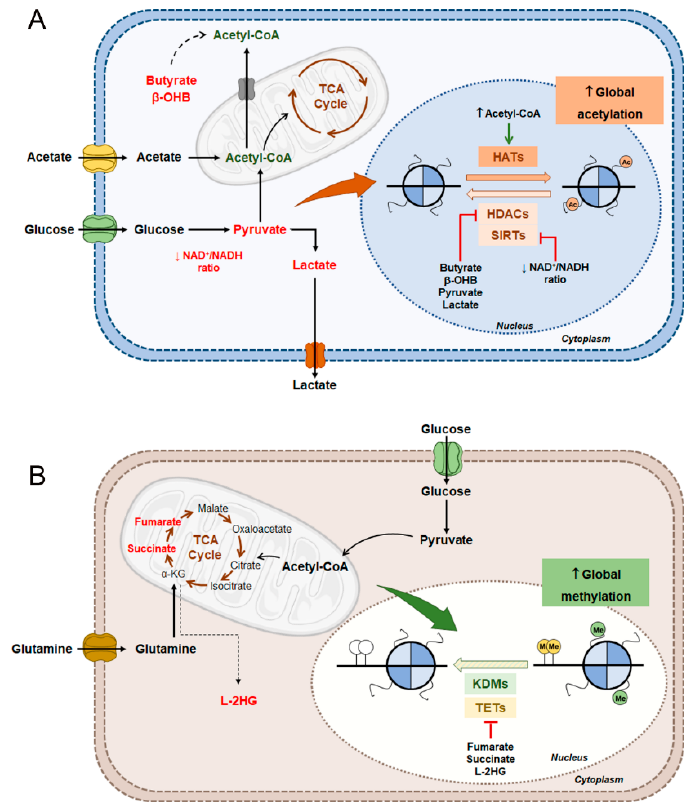
Figure 5. Putative metabolic reprogramming of epigenetic enzymes in RCC. Epigenetic mechanisms can be modulated by the available metabolites in the cell, contributing to aberrant gene expression.